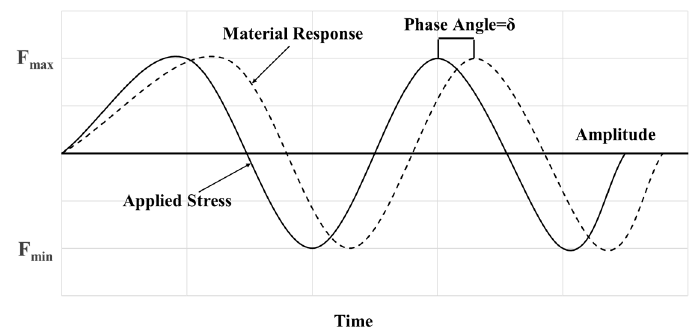
Figure 10. Tan ( δ ) vs. Log (N) graph for the 6AL10b specimen.